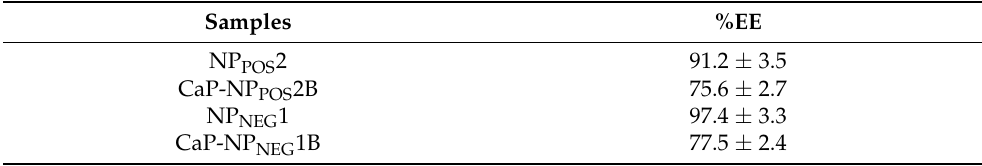
Table 7. Sudan Red III entrapment efficiency (%EE) in